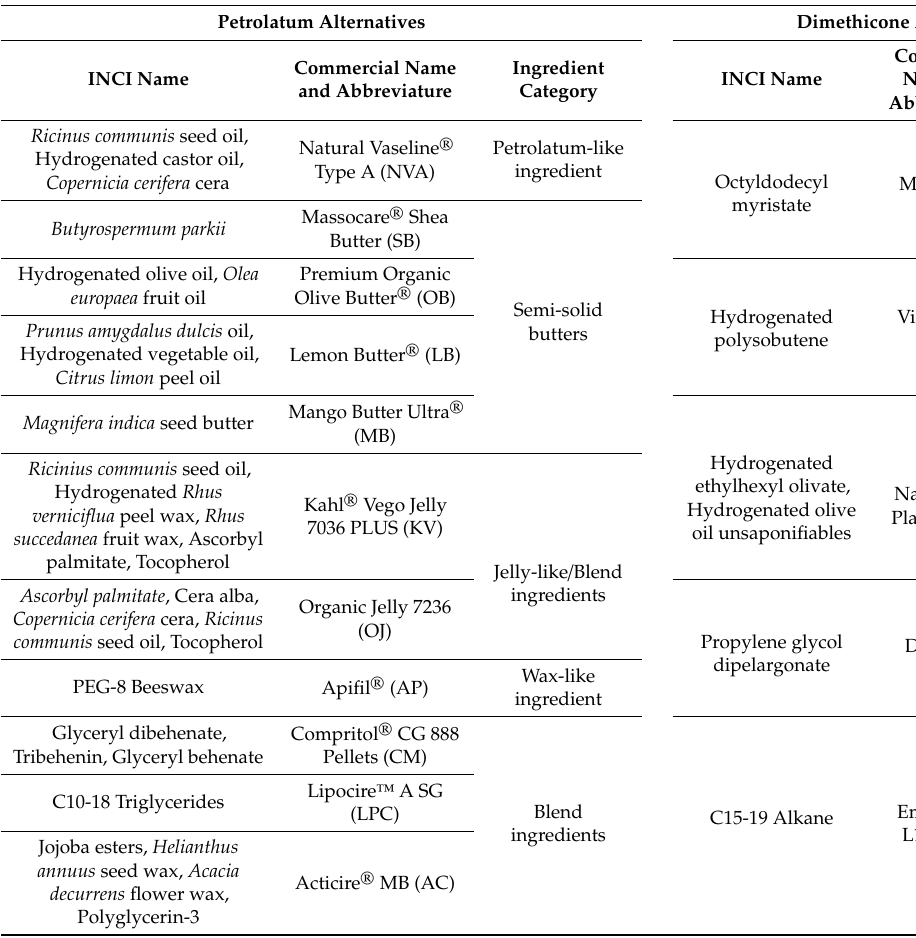
Table 1. Description of the selected petrolatum, dimethicone, and phenoxyethanol